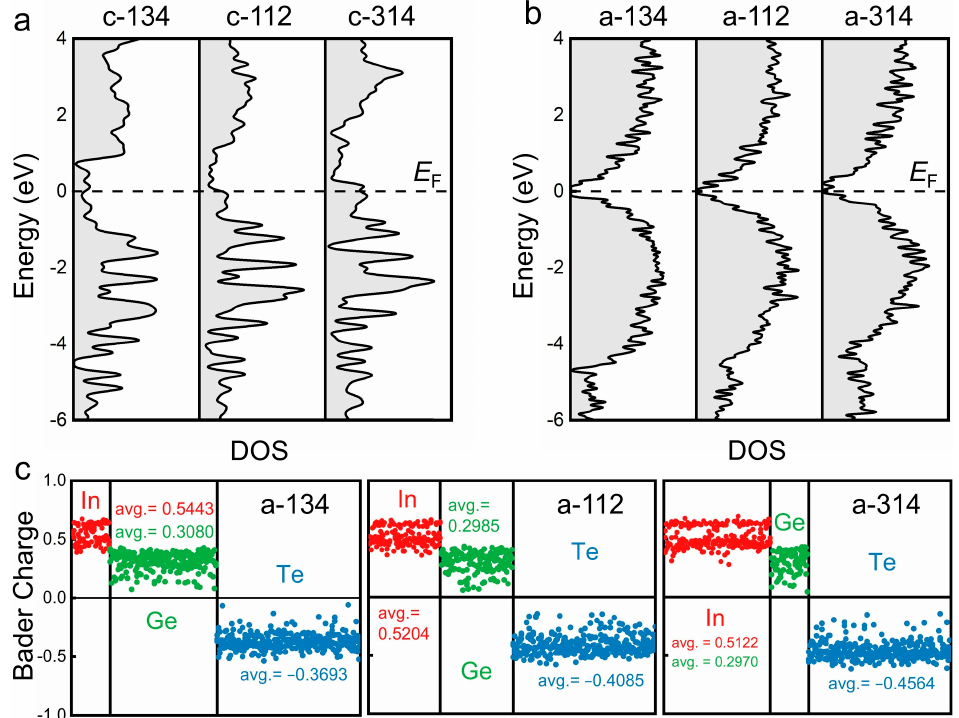
Figure 4. Density of states (DOS) for the ( a ) crystalline and ( b ) amorphous structures of the three In-Ge-Te compositions. The “c-134”, “c-112” and “c-314” represent crystalline InGe 3 Te 4 , InGeTe 2 and In 3 GeTe 4 , respectively. ( c ) Bader charges (in electrons per atom) of all atoms in the three amorphous structures.